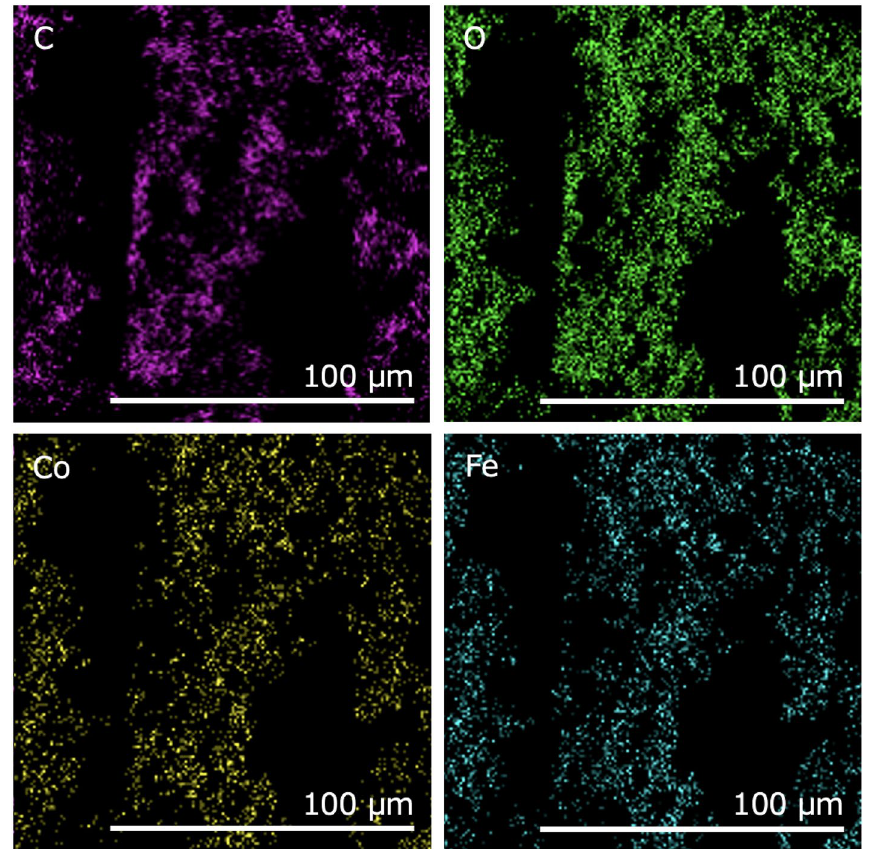
Figure 5. EDS mappings of the 27.5 vol% CNF–CoFe 2 O 4 composite paper with 27.5 vol% CoFe 2 O 4